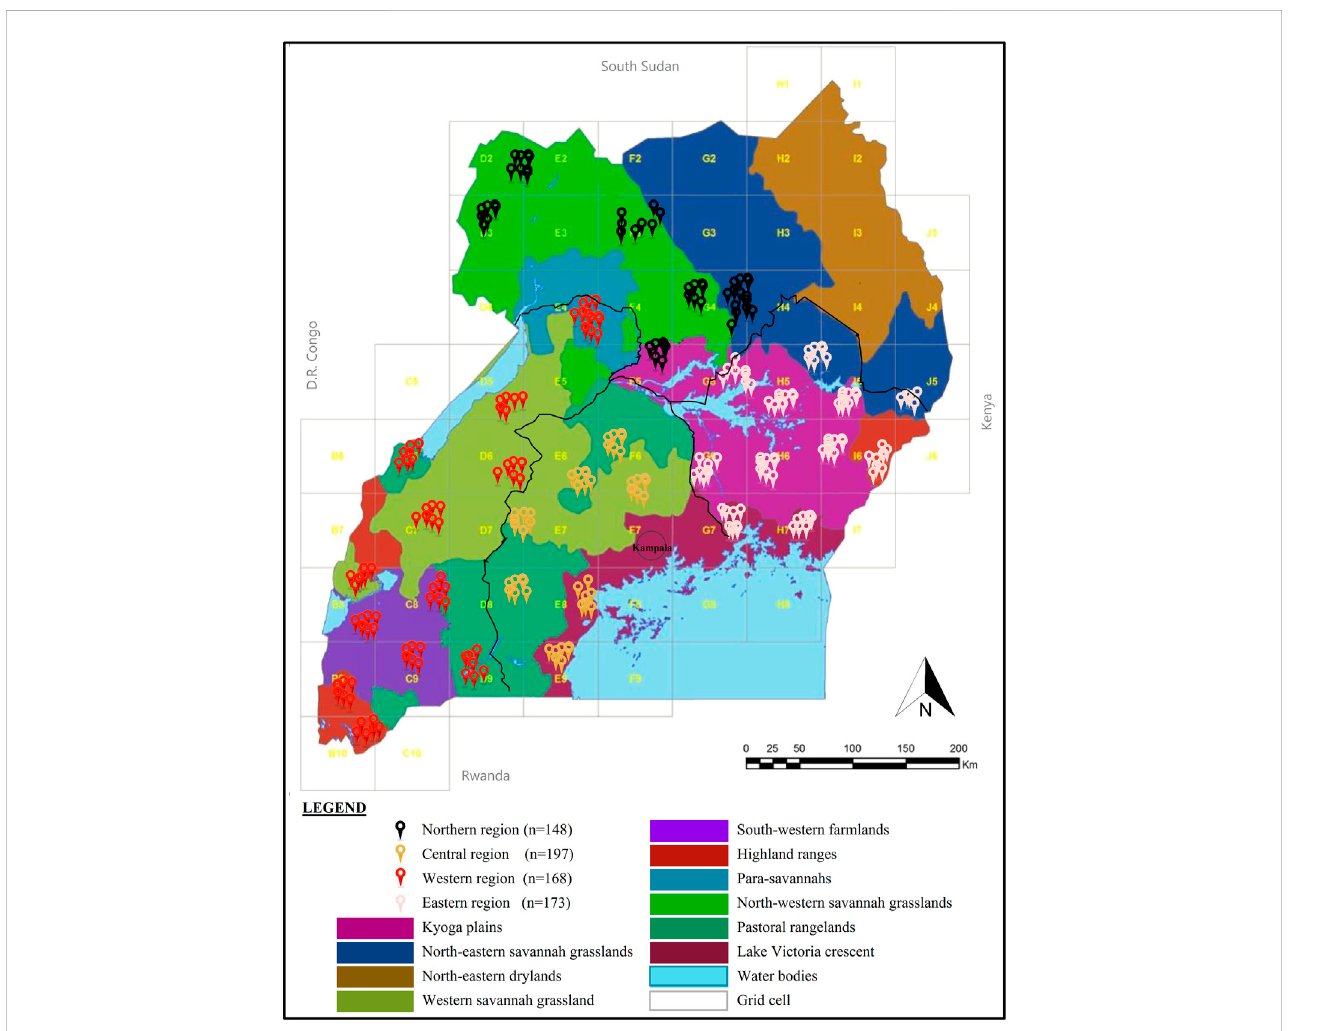
FIGURE 1 Mapofthestudy locations oftheindigenouschickensinUganda.The sampledistributionofthe293randomlyselected householdsfrom villages( > 5 km apart) was obtained from grid cells of approx. 50 km 2 across the AEZs of Uganda to ensure the collection of landscape data.